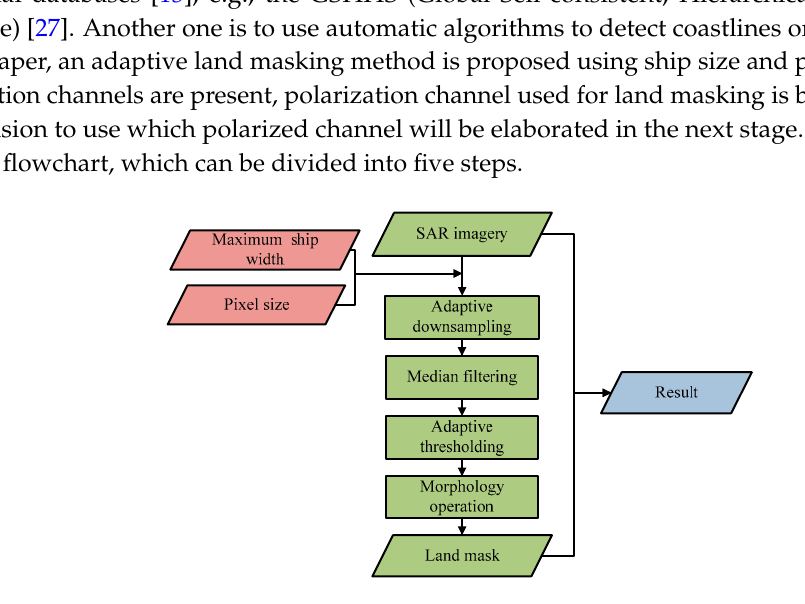
Figure 2. Detailed flow of land masking.